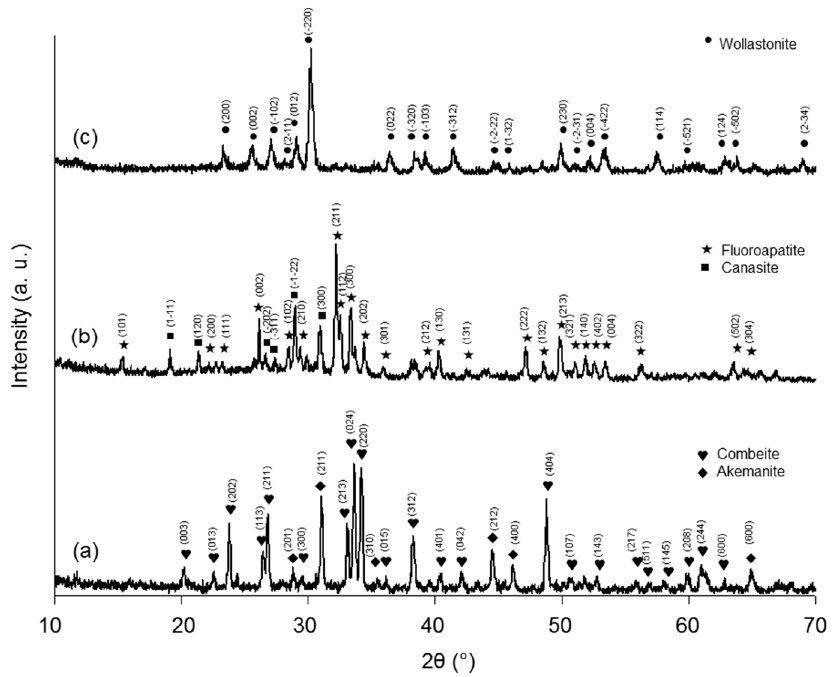
Figure 3. XRD patterns of the sintered materials: ( a ) TT-CEL2; ( b ) TT-FaGC; and ( c ) TT-SCNA.